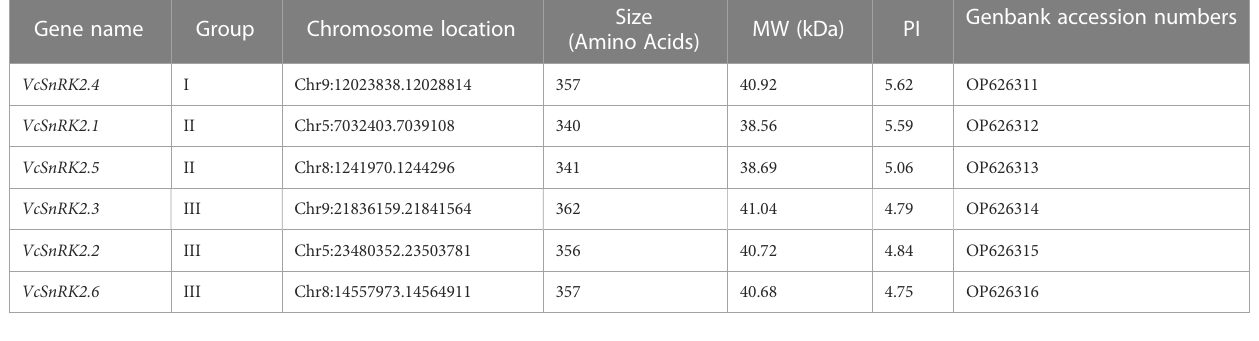
TABLE 1 Characteristics of VcSnRK2 genes in blueberry ( V. corymbosum ).